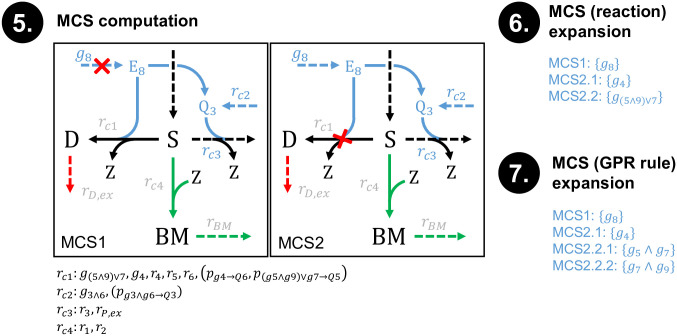
Continuation of the exemplary gene MCS calculation from Fig 4.Shown are the three final steps of MCS computation (step 5), expansion/decompression of MCS at the reaction (step 6) and then at the gene (step 7) level. For better readability, the protein pool pseudo-reactions (p) connecting the enzymes (E) with the enzyme pools (Q) were not labeled in the network in step 5.